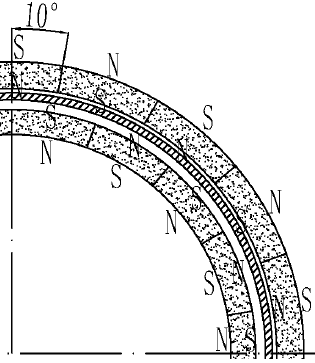
Figure 19. Arrangement of magnetic blocks.